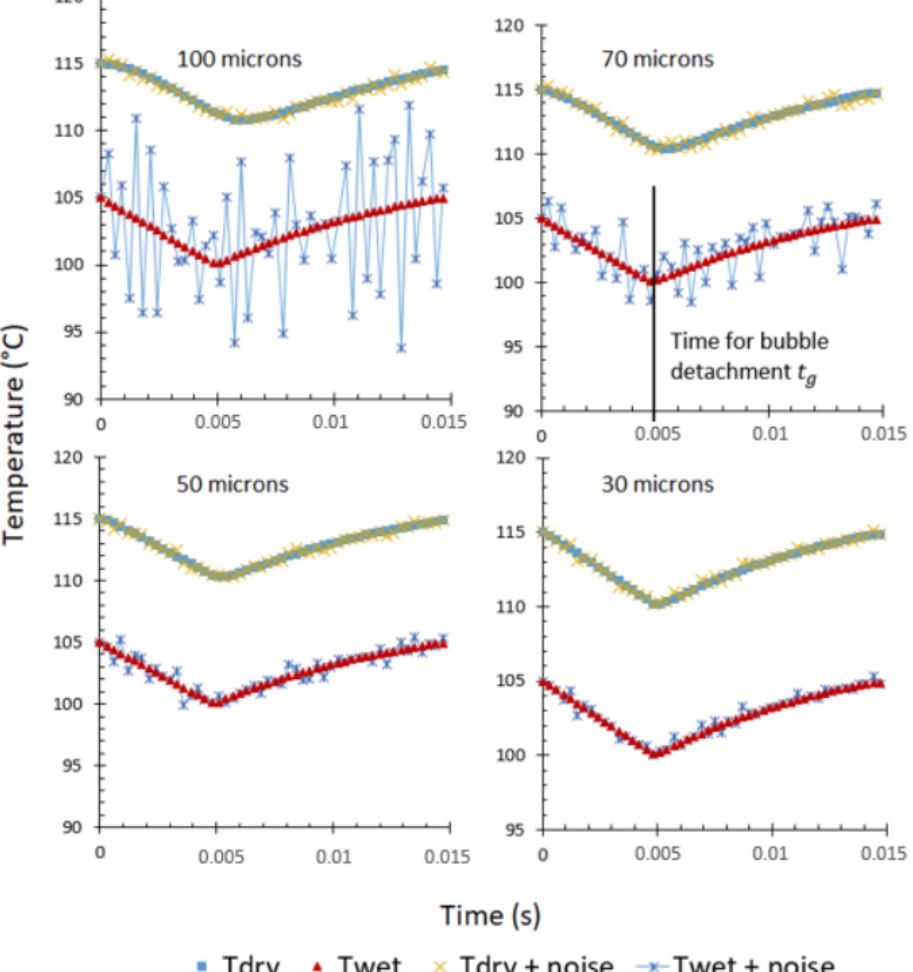
Figure 15. Illustration of the noise amplification solving the inverse problem for various thicknesses. This problem–solution was solved with the following values: N = 1000, n = 50, t g = 0.005s, t w = 0.01s, ∆ t = 0.00031s, P = 1bar, I = 400A, ∆ T = 5 ◦ C, C P = 502 J/K · kg, λ = 15 W/m · K, ρ = 7960 kg/m 3